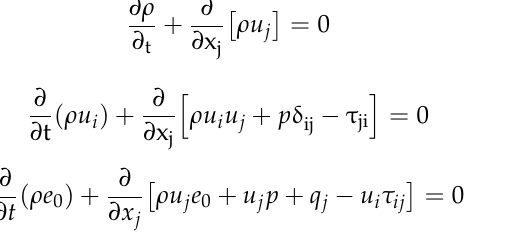
Figure 2. Boundary conditions of the simulation scheme.